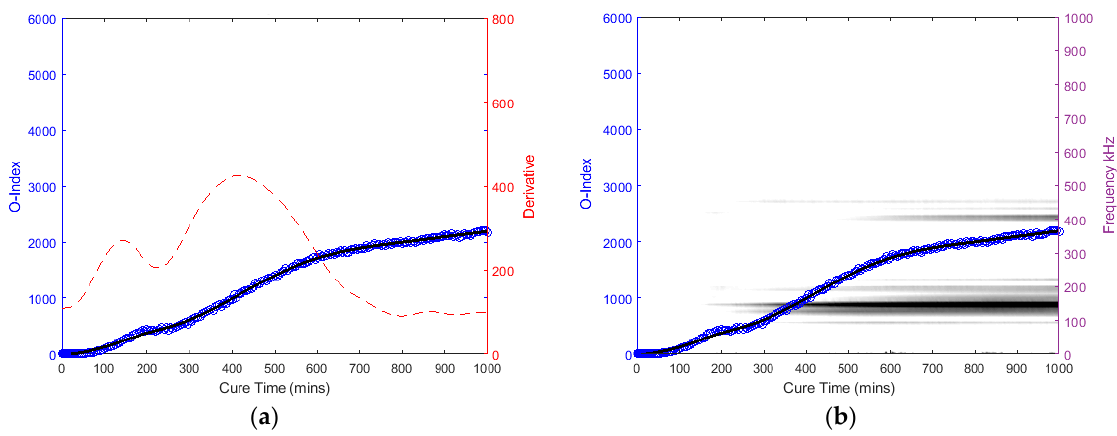
Figure 14. Oval specimen (Near): O-Index with ( a ) its time derivative and ( b ) its change in frequency.